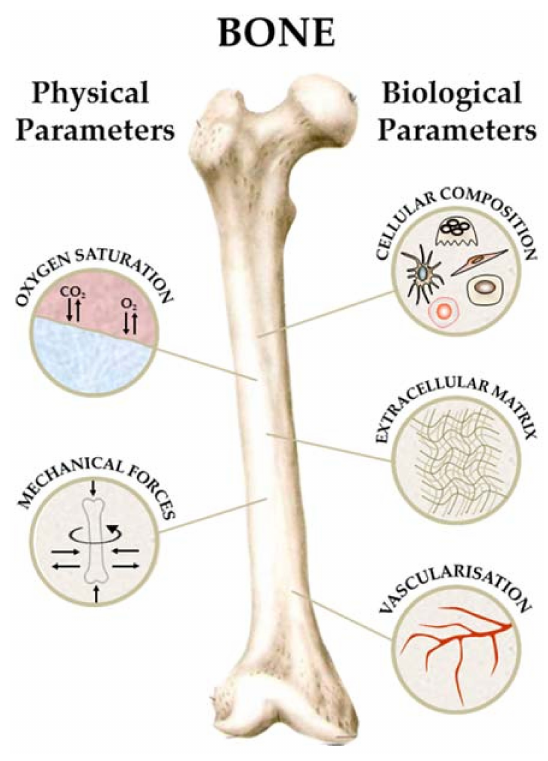
Figure 3. Schematic summary of key parameters in bone